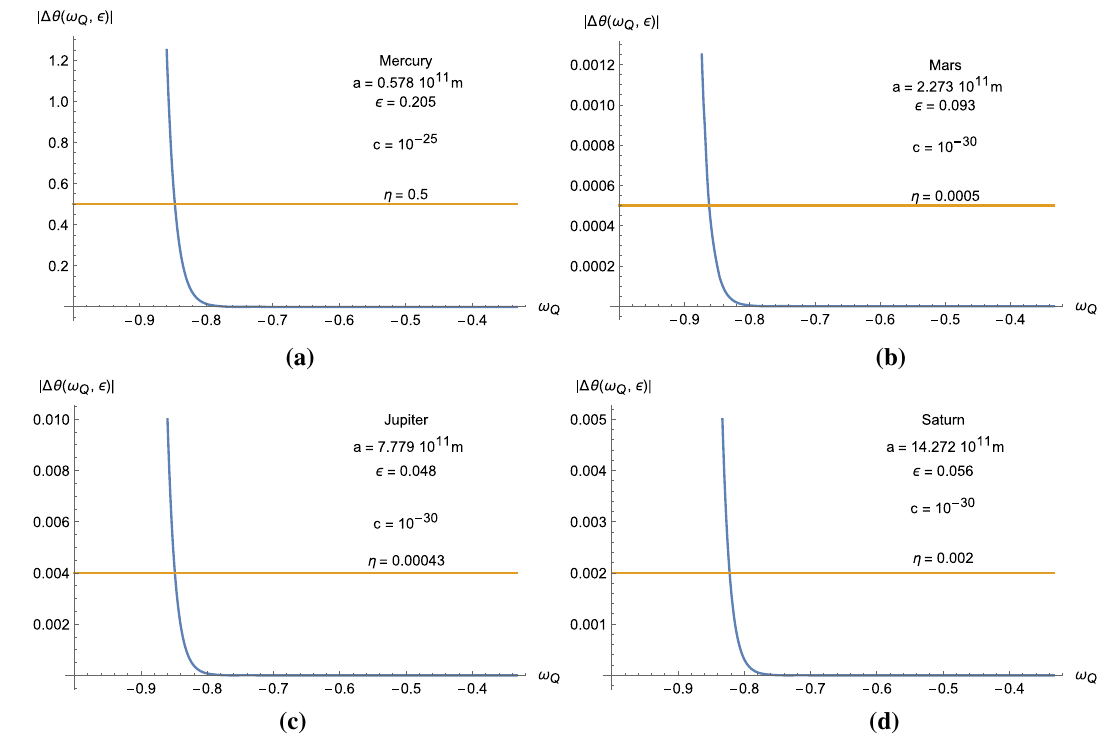
Fig. 4 a | (cid:7)θ(ω Q ,(cid:10)) | vs ω Q for Mercury. b | (cid:7)θ(ω Q ,(cid:10)) | vs ω Q for Mars. c | (cid:7)θ(ω Q ,(cid:10)) | vs ω Q for Jupiter. d | (cid:7)θ(ω Q ,(cid:10)) | vs ω Q for Saturn